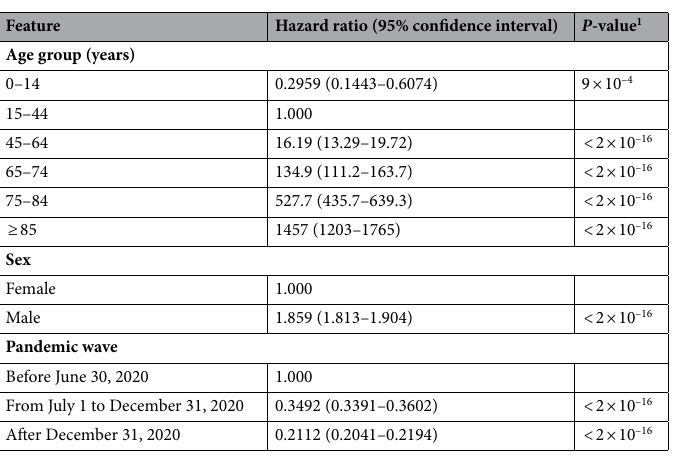
Table 3. Factors associated with death in non-hospitalized subjects in the Italian national database. Among non-hospitalized persons, 101,300 cases were excluded due to incomplete or erroneous data, for a total of 3,816,311 SARS-CoV-2-positive subjects analyzed and 27,409 deaths within 30 days of diagnosis. 1 Multivariable weighted Cox analysis (non-proportional hazards model).